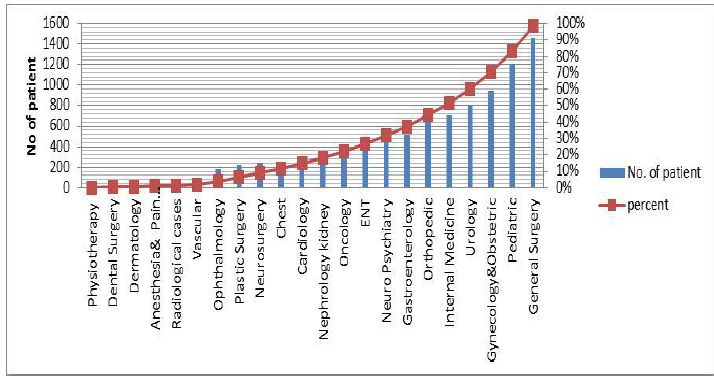
Fig. 4. Pareto chart for hospital departments versus the patient number in year 2010.